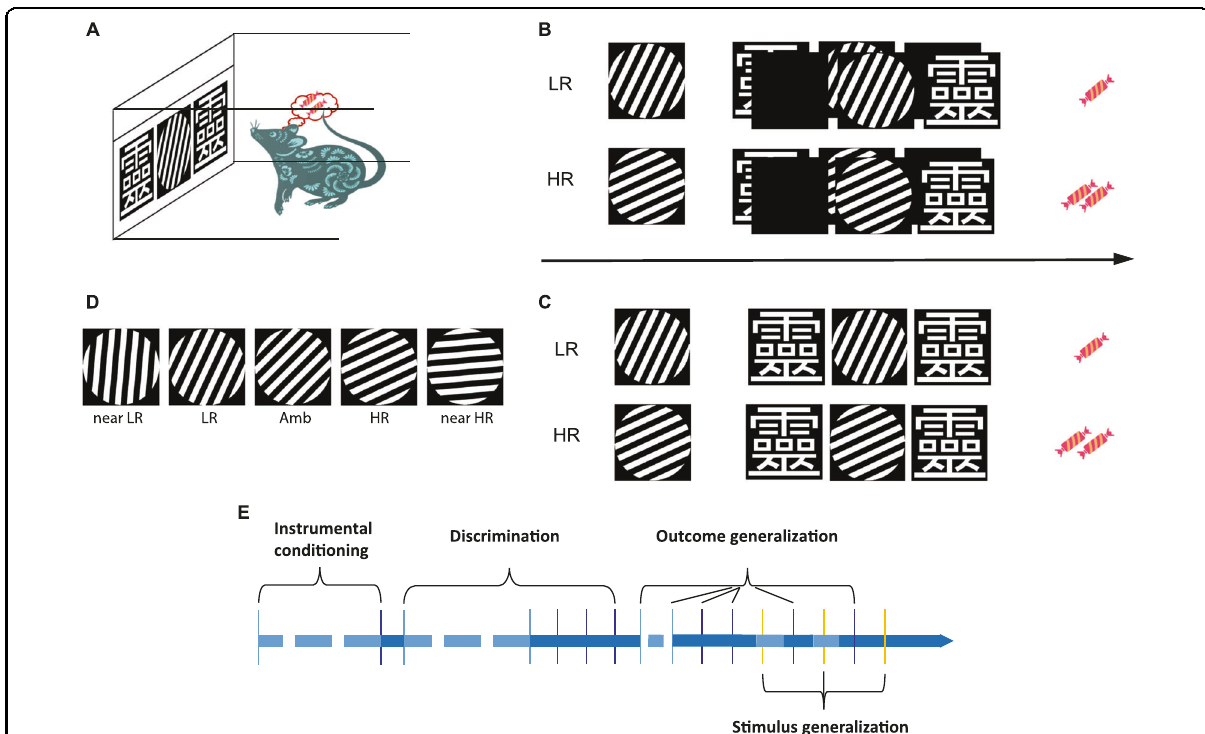
Fig. 1 A representative schematic view of the experimental procedures. A A representative rat in an operant chamber equipped with a touchscreen. B A high-reward (HR) trial and a low-reward (LR) trial sequence in the stage of instrumental learning. The rat was allowed to touch the stimulus of white and black gratings (phase one), which was followed by the random presentation of a reporter image “ 靈 ” on either the left or the right side of the screen (phase two). Then, the rat was allowed to touch this single reporter image, leading to the delivery of one sucrose pellet for LR, and two sucrose pellets for HR trials (phase three). C A HR and an LR trial sequence in the stage of discrimination learning. During a HR trial, the rat was allowed to touch the 65° grating stimulus (phase one). Then, if it was touched, two reporter images were presented on the left and right side of the screen simultaneously (phase two). A correct response (reporter image on the right screen was touched) produced two sucrose pellets (phase three). During an LR trial, the rat was allowed to touch the 25° grating stimulus (phase one). Then if it was touched, two reporter images were presented on the left and right side of the screen simultaneously (phase two). A correct response (reporter image on the left screen was touched) produced one sucrose pellet (phase three). An incorrect response initiated a correction trial for both LR and HR trials. Correction trial is the same type of trial as the previous trial during which the subject responded incorrectly. D A representation of all the stimulus images during the generalization phase. The degrees of LR and HR stimuli are 25° and 65°, respectively. The near-LR stimulus is 5°, the near-HR stimulus is 85°, and the ambiguous (Amb) stimulus is 45°. E The experiment fl owchart. Each vertical line represents one session and the horizontal line represents the timeline. The dash horizontal lines denoting the sessions between the two vertical lines are the same. Solid lines between two vertical lines denoting the two sessions represented by the lines took place on two consecutive days. Blue lines represent sessions during instrumental conditioning and discrimination. Light-blue vertical lines represent the sessions that the ratio of correct response is below the criteria (90% correct trials per session for instrumental conditioning, 70% correct trials per session for discrimination). Dark-blue vertical lines represent the sessions that rats reached the criteria. Yellow vertical lines represent sessions during stimulus